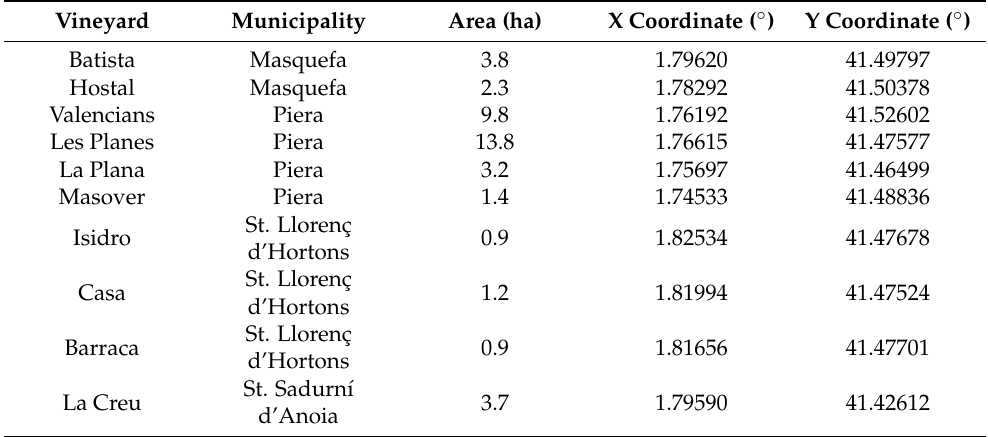
Table 1. Location and area of the vineyards studied. Coordinates are provided in decimal degrees for a single vine at each vineyard. Sampled vines were less than 5 m apart from each other.